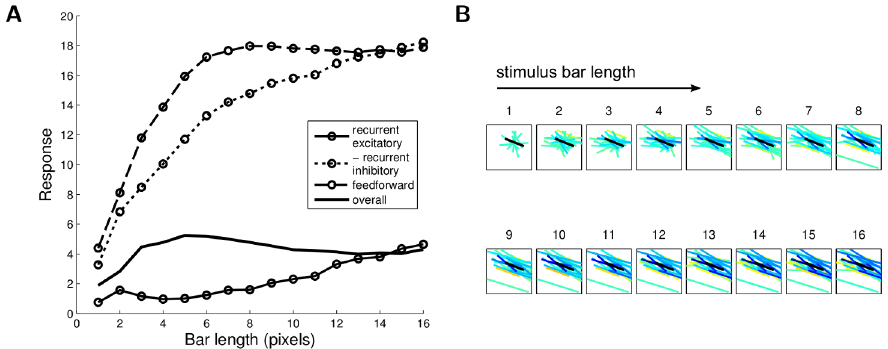
Figure 9. Decomposition of the recurrent inputs contributing to the end-stopping effect. (A) Overall decomposition of the response into recurrent excitatory, inhibitory, and feedforward components; (B) Locations and orientations of the CRFs of cells contributing to the recurrent excitatory and inhibitory signals at different bar lengths. Only CRFs with significant influences are displayed (i.e., DS w i , w m TD a i ( t ) w 0 : 1 at steady state). The warmer color (yellow) represents the location and orientation of the CRFs for cells contributing to recurrent excitation, the cooler color (blue and cyan) represents the CRFs for cells contributing to recurrent inhibition. Higher contrast in the color indicates a stronger excitatory or inhibitory effect on the target cell. The black bar represents the target cell CRF. Note that as the bar length increases, the suppressive effect is mostly due to recurrent inhibition from cells that are a better description of the new stimulus (and therefore would be a more efficient stimulus description according to the sparse coding model).